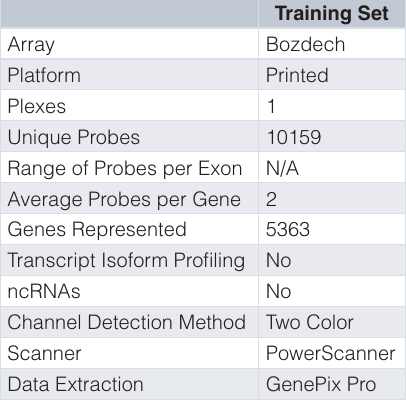
Table 2. IC training data information. 50 (Adapted from Turnbull et al ., (2017) PLoS One 22 ).